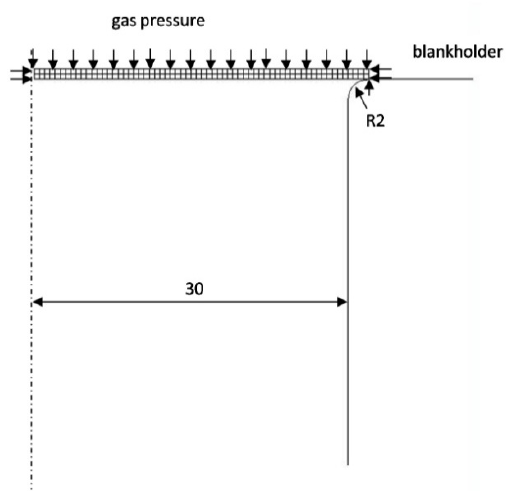
Figure 2. FEM schematization of the blow forming process.